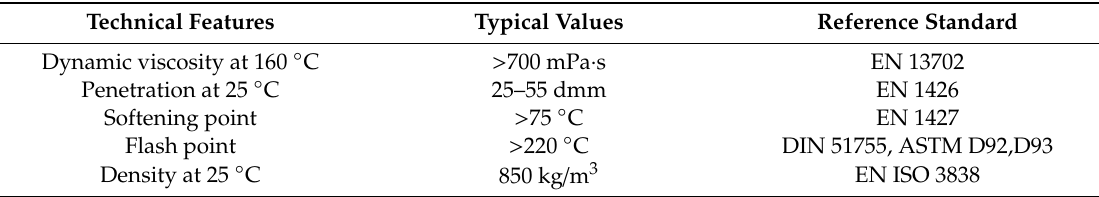
Table 1. Technical properties of the polymeric